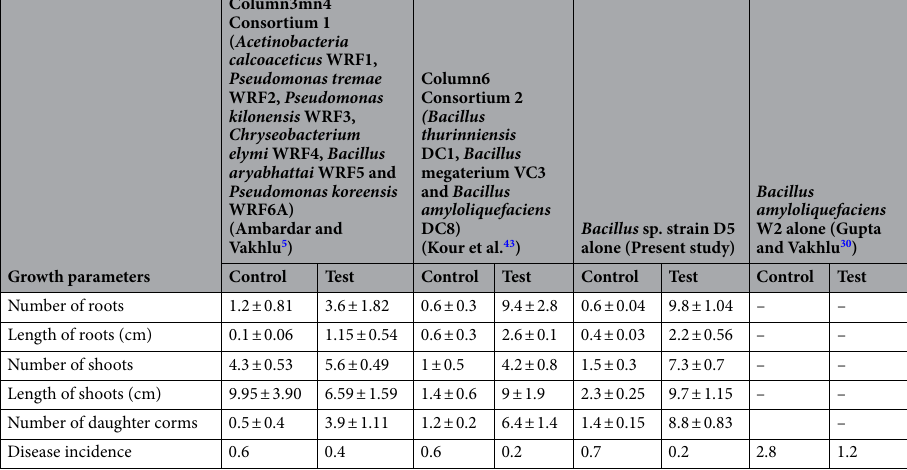
Table 5. Comparative table for results of pot trials with different native bio-formulations.